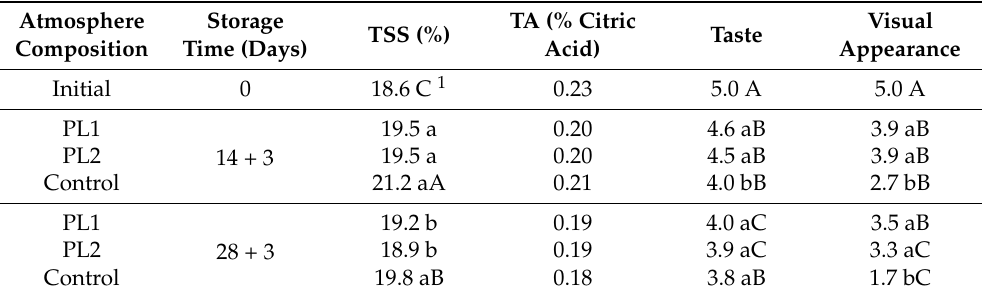
Table 2. Total soluble solids (TSS), titratable acidity (TA), taste and visual appearance of Bursa Siyahi fig cultivar under palliflex storage system during cold storage + 3 days at